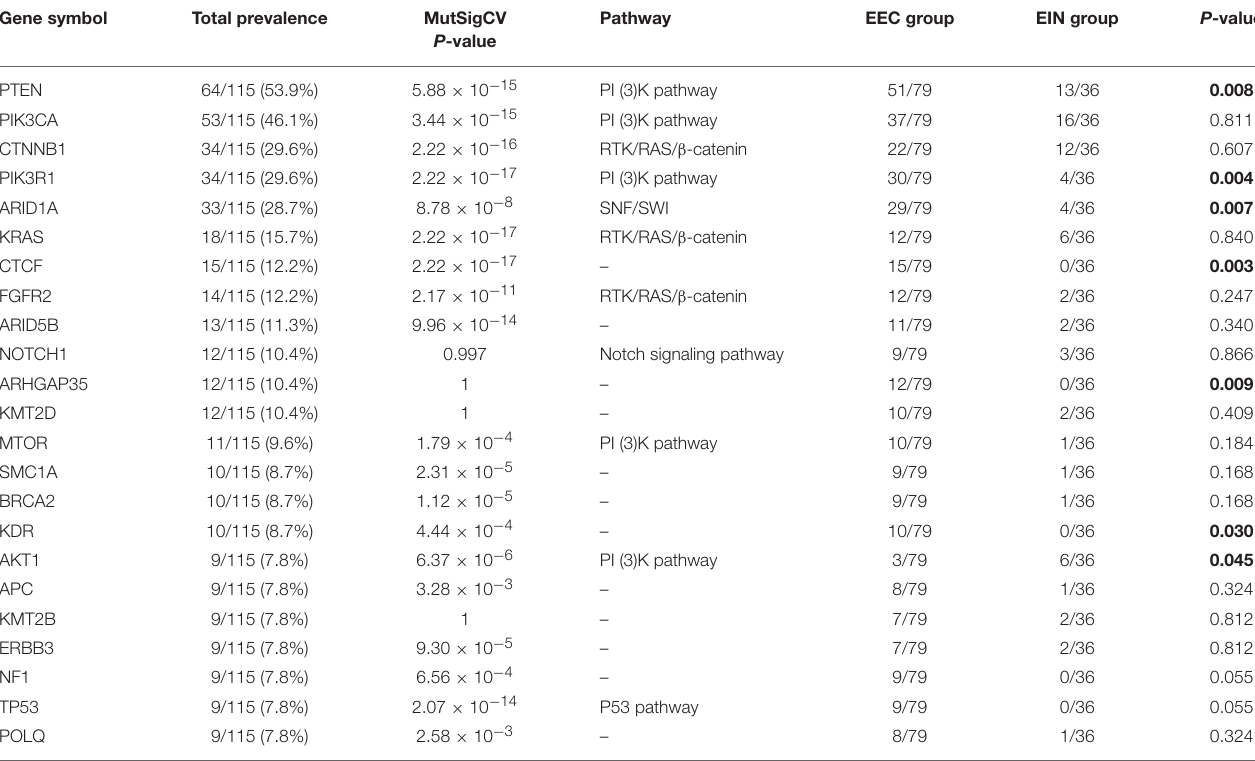
TABLE 2 | The highly mutated genes (mutation frequency ≥ 9) in all samples. Gene